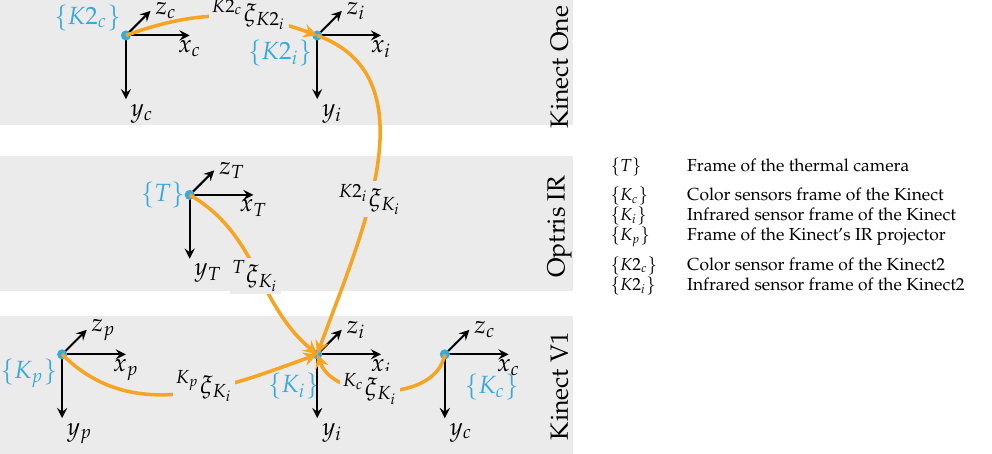
Figure 5. Transformation tree for the system’s sensors: The infrared frame of the Kinect is used as reference for the world coordinate origin { 0 } . The manufacturer already calibrates the 3D sensor’s own sensor frames. To obtain the transformation between the Kinect V1 and Kinect One, the IR sensors from both cameras are taken as a